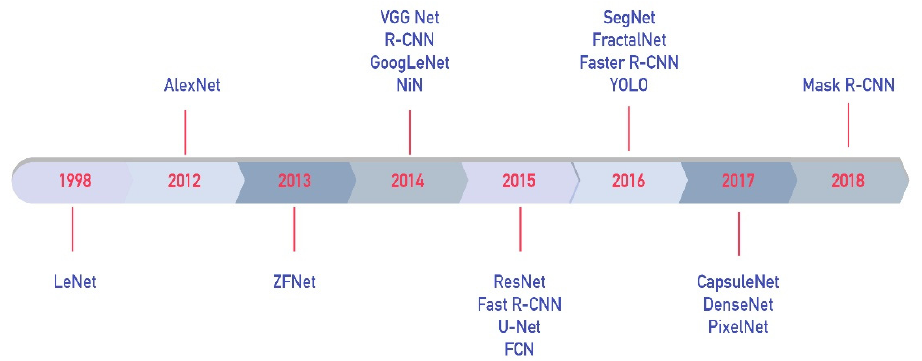
Figure 3. CNN Architectures